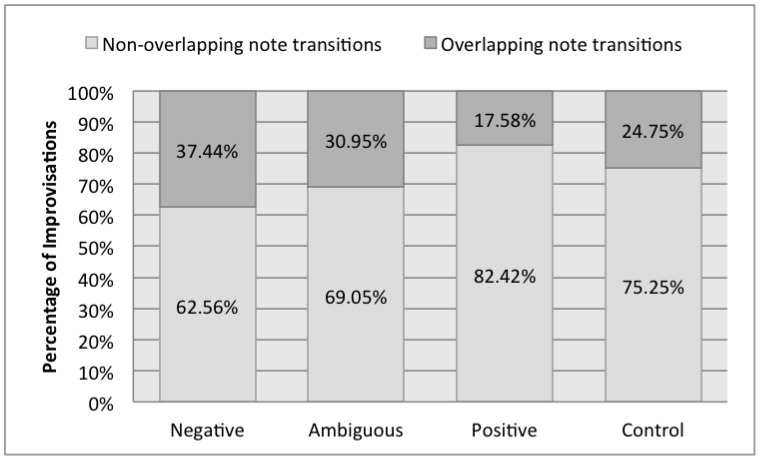
Overlapping and non-overlapping note transitions during one-handed improvisations.